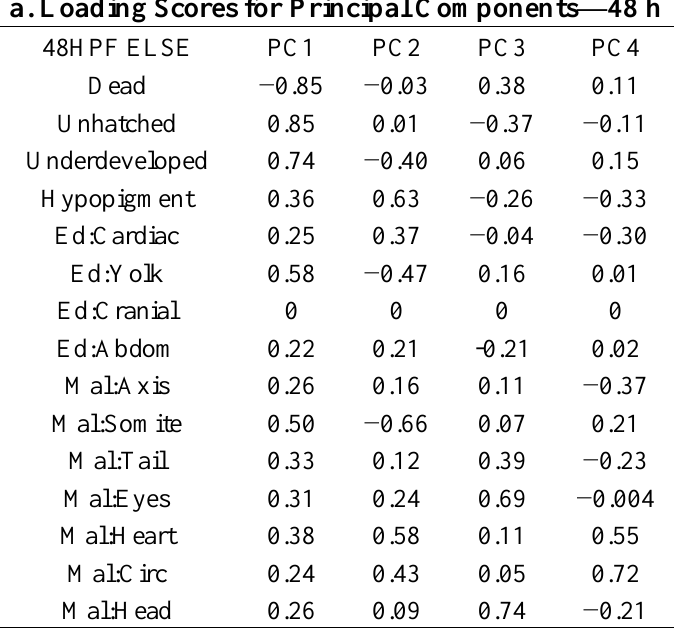
Table 2. Principal components loading scores of early life-stage endpoints (ELSE). Loading scores with an absolute value greater than 0.4 are displayed in bold. ( a ) 48 h post- fertilization, ( b ) 72 h